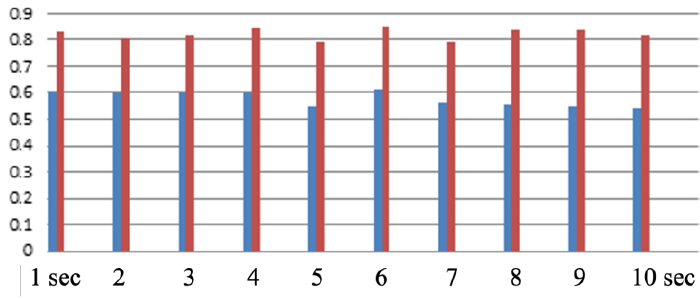
Figure 11. The Kappa values of input data average (blue bars for SVM and red bars for RF).